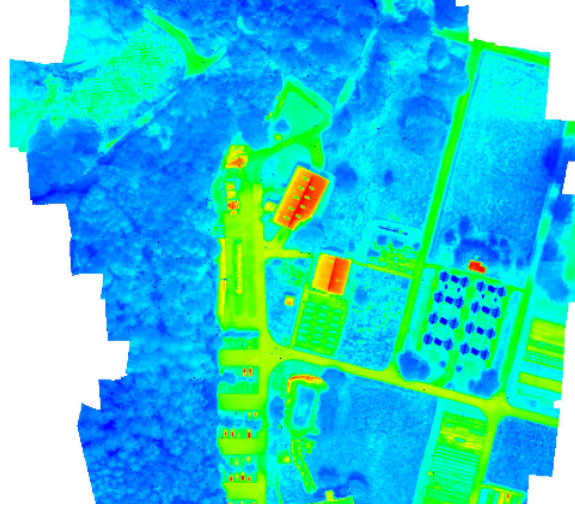
Figure 13: Thermal orthophoto of test site "WSL Garten".